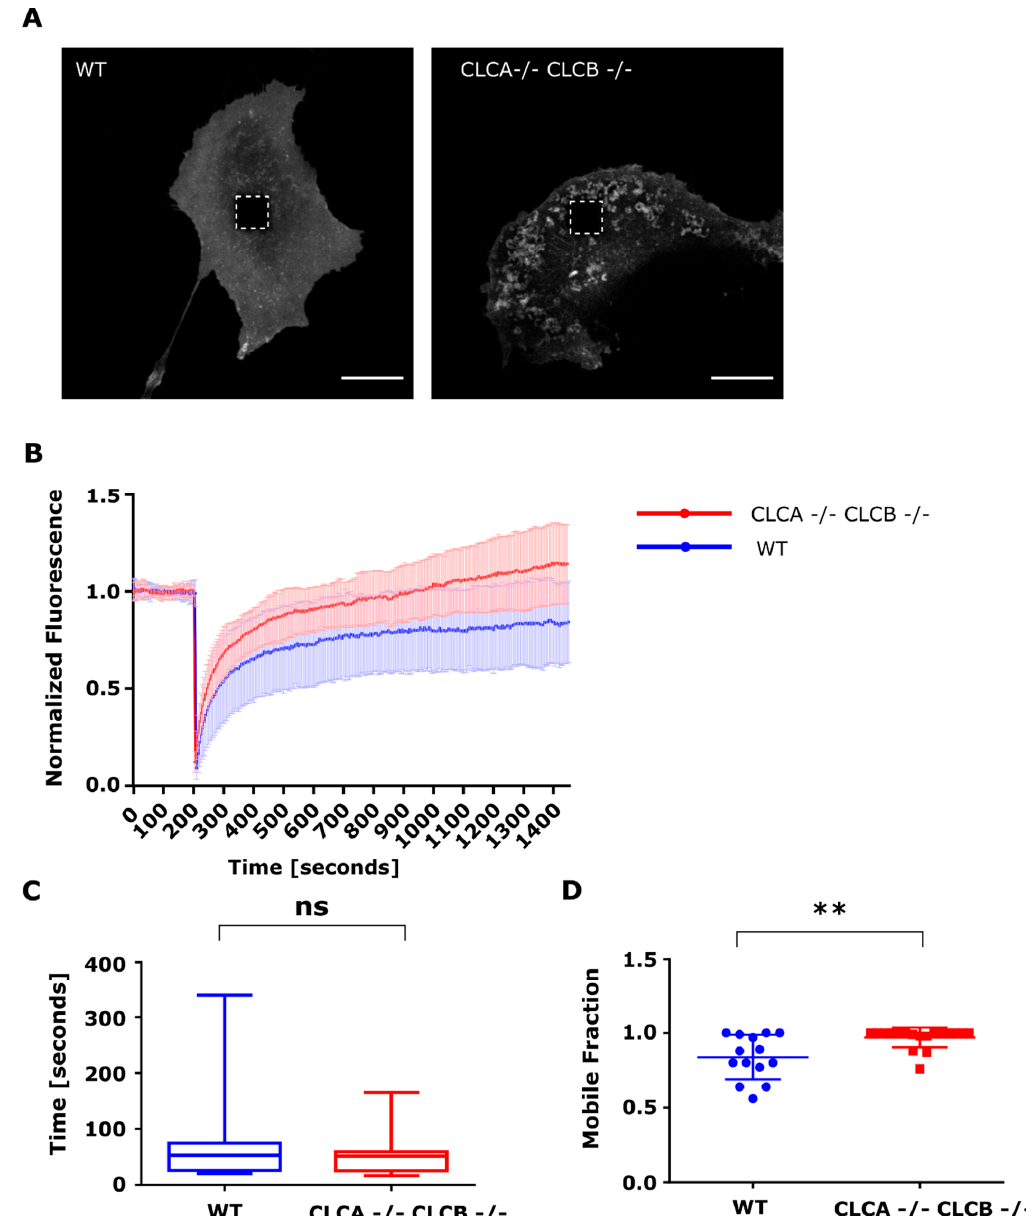
Figure 7 . Fluorescence recovery after photobleaching of MMP14-pHluorin. ( A ) Representative live-cell confocal spinning disc microscopy of U373 WT and CLCA − / − CLCB − / − transiently expressing MMP14-pHluorin. Live-cell confocal imaging was performed for a total of 25 min at a frame rate of 5 s per frame. The scale bar equals 20 µm. Highlighted area indicates FRAP region. ( B ) Normalized fluorescence of FRAP recovery curves. Normalized mean fluorescence intensity profiles of WT (blue) and CLCA − / − CLCB − / − cells (red) before and after FRAP. Shown are mean and SD computed from 14 WT and 18 CLCA − / − CLCB − / − cells FRAP recovery curves. Standard deviations are shown. ( C ) t-Half of MMP14-pHluorin in U373 WT and CLCA − / − CLCB − / − cells. T-Half was calculated from 14 (WT) and 18 (CLCA − / − CLCB − / − ) FRAP recovery events, each FRAP event was monitored in a different cell. Mean with SD are shown. Statistical analysis: unpaired t test, ns. All FRAP analysis was performed using the EasyFRAP-web tool. ( D ) Mobile fraction of MMP14-pHluorin in U373 WT and CLCA − / − CLCB − / − cells. Mobile fraction was calculated from 14 (WT) and 18 (CLCA − / − CLCB − / − ) FRAP recovery events. Mean with SD are shown. Statistical analysis: unpaired t test, ** p = 0.0069.